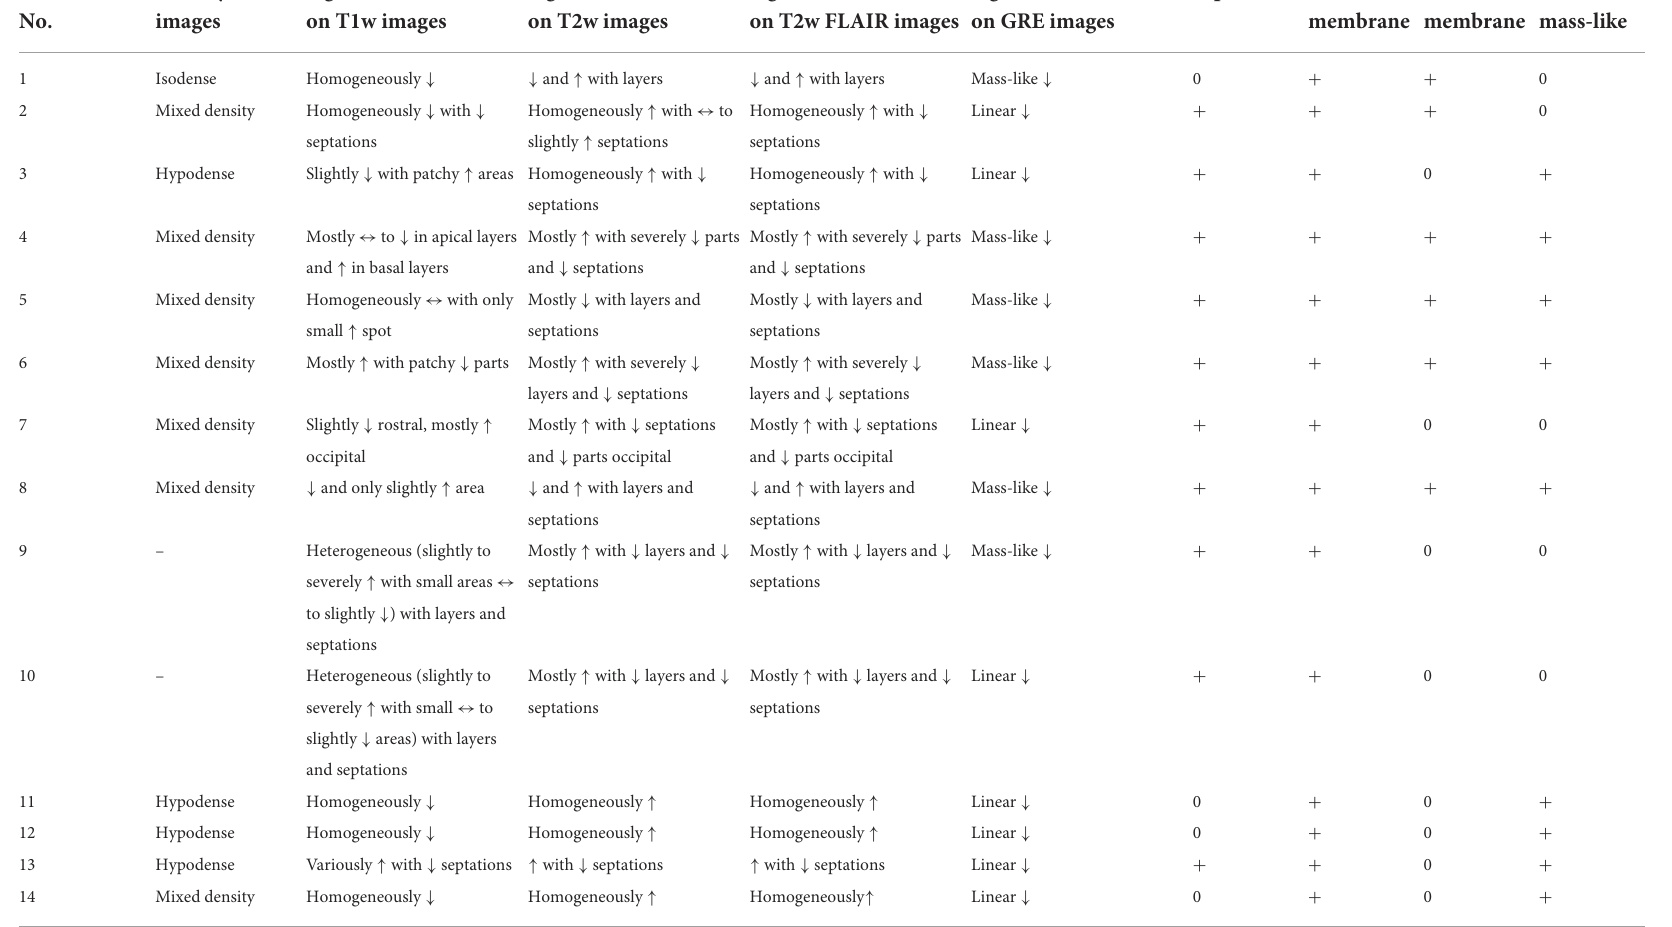
TABLE 2 MRI and CT characteristics of chronic subdural hematomas (cSDHs).